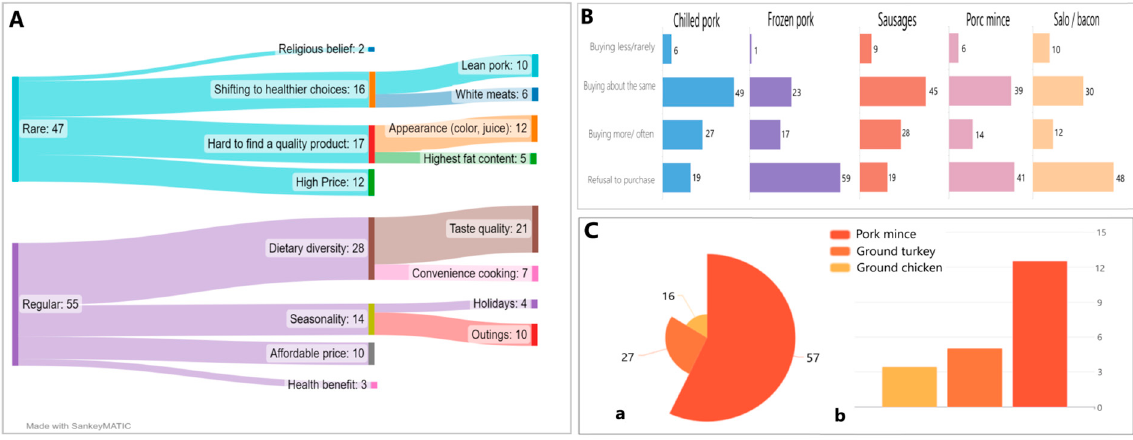
Figure 1. Russian consumer attitude towards pork attributes: ( A ) Russian consumer motives for choosing pork (%); ( B ) Consumer attitudes towards pork products bought over the past 1–2 years, % of respondents (survey 1 ); ( C ) The Russian consumers preferences for minced meat: ( a ) Net Promoter Score; ( b ) Percentage of mentions of fat content. Note: 1 Ponamoreva E. Trends Laboratory